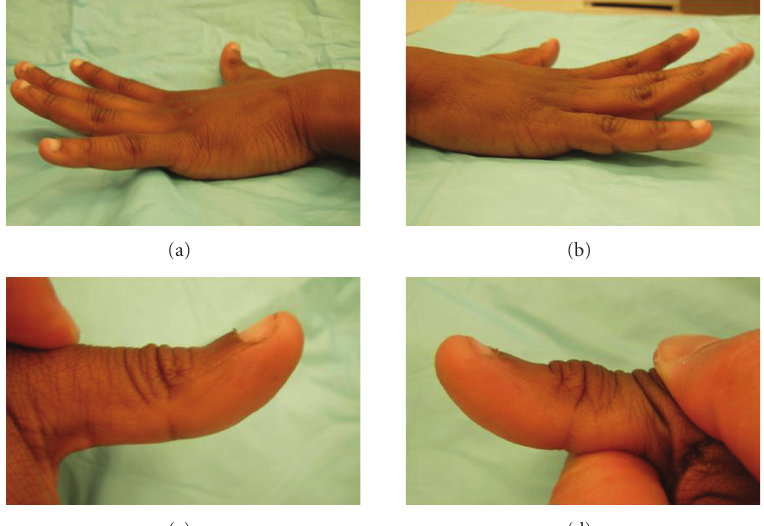
Figure 1: Seven months postoperative range of motion of 13-year-old right hand dominant male who sustained glass laceration to his right dorsal forearm. The range of motion of the left hand is shown compared to the right: (a) left small finger extension 20 ◦ , (b) right finger small finger extension 15 ◦ , (c) left thumb IP extension 35 ◦ with proximal phalanx extended, and (d) right thumb IP flexion 20 ◦ with proximal phalanx